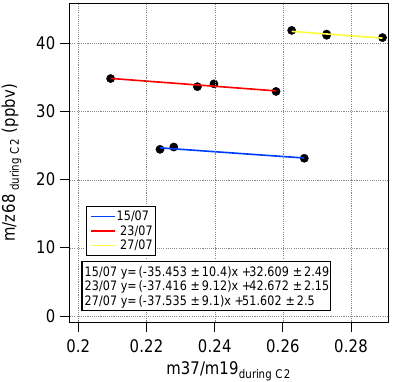
Figure 2. Linear least squares fit of m/z 68 during C2 vs. m 37 /m 19 during C2 for the tests conducted on the field to assess the correc- tion for humidity differences between C2 and C3 for CRM-LSCE. Equation coefficients are reported with one standard deviation. Dif- ferences in the intercepts are due to a less efficient tracking of ab- solute humidity from m 37 /m 19 on a longer time